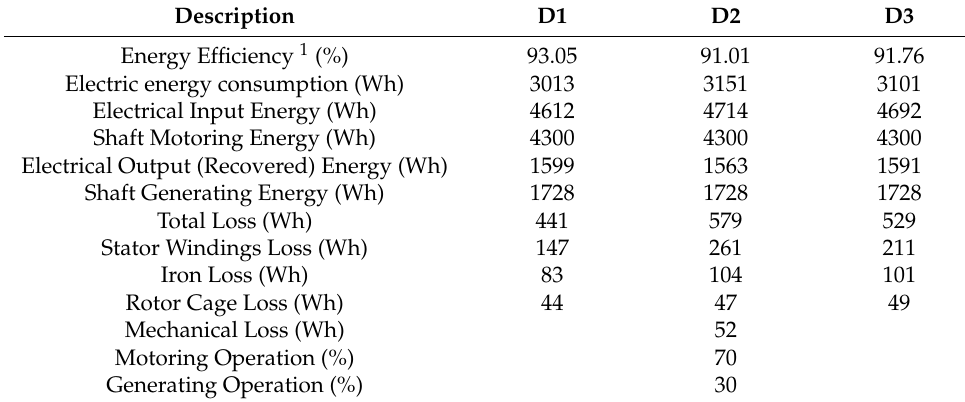
Table 7. Results for the WLTP class 3 drive